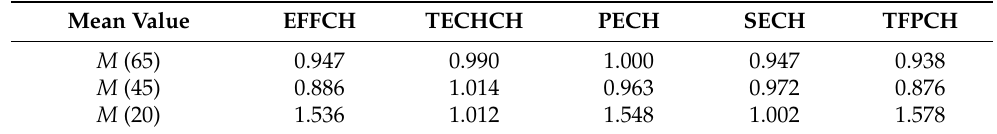
Table 4. Decomposition mean table of enterprise total factor